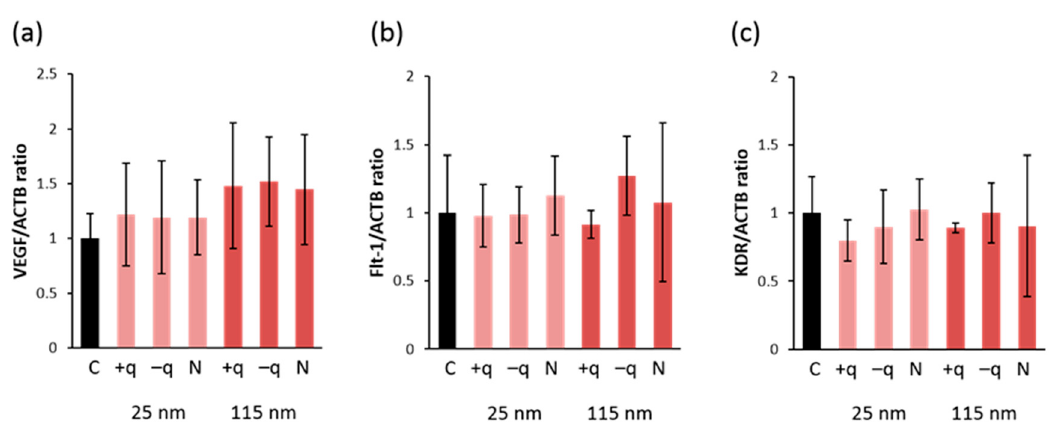
Figure 3. Gene expression of VEGFa and VEGF receptors in zebrafish. Expression levels of ( a ) VEGFa and VEGF receptors: ( b ) Flt-1 and ( c ) KDR in embryos exposed to 100 mg/L of 25 or 115 nm SiO 2 NPs with different surface-charge at 48 and 72 hpf. The mRNA levels were normalized by the amount of β -action mRNA. Data are represented as mean ± SD.